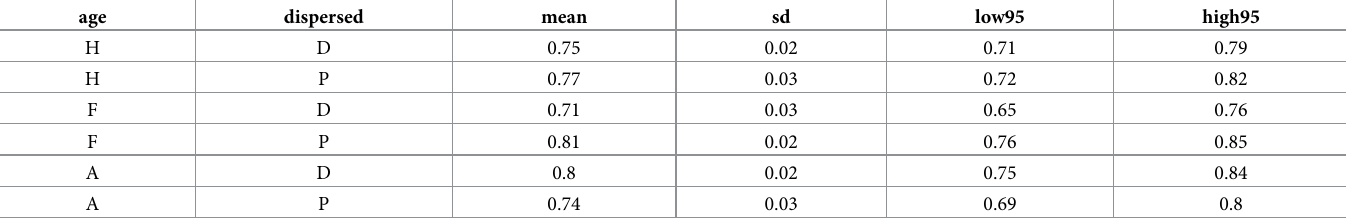
Table 1. Summaries proportion of methylated loci for hatchlings (H), fledglings (F), and adults (A) that either dispersed (D) or remained philopatric (P). Values represent the mean, standard deviation (sd) and upper and lower 95% credible intervals from a Bayesian GLMM.